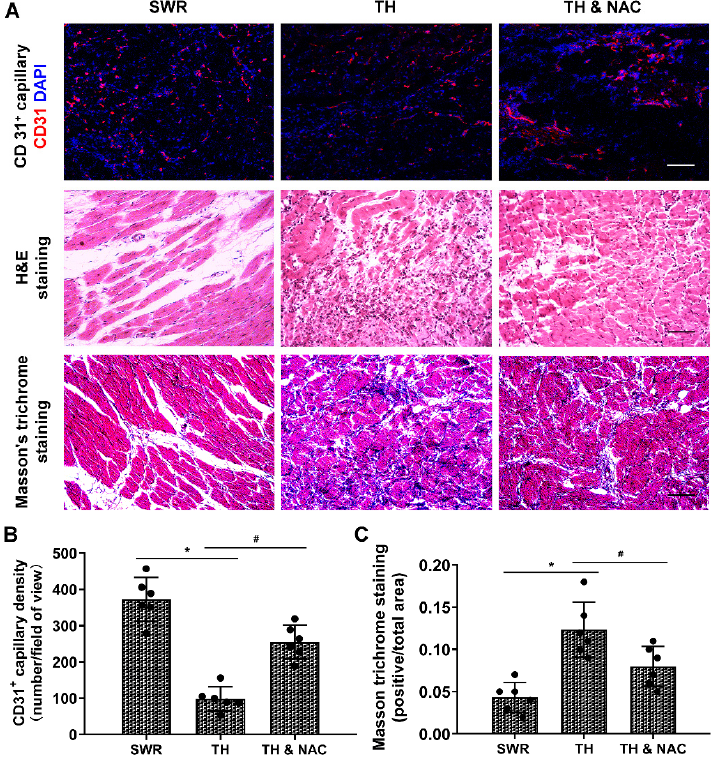
Figure 4. NAC treatment improved CD31 + capillary density and preserved muscular structure in diabetic ischemic limb. Ischemic muscle tissues were harvested at day 21 after CLI for histological analysis. CD31 + capillary density ( A ) was significantly decreased with disorganized muscular structure ( B ) and increased tissue fibrosis ( C ) in diabetic ischemic limb compared to the controls (* p <